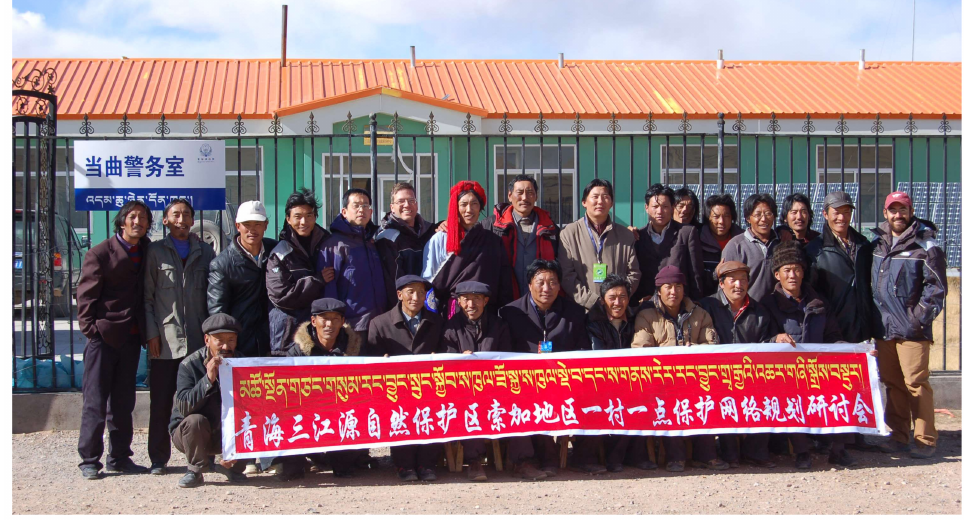
Figure 9. Co-management meeting with nature reserve and village representatives, October